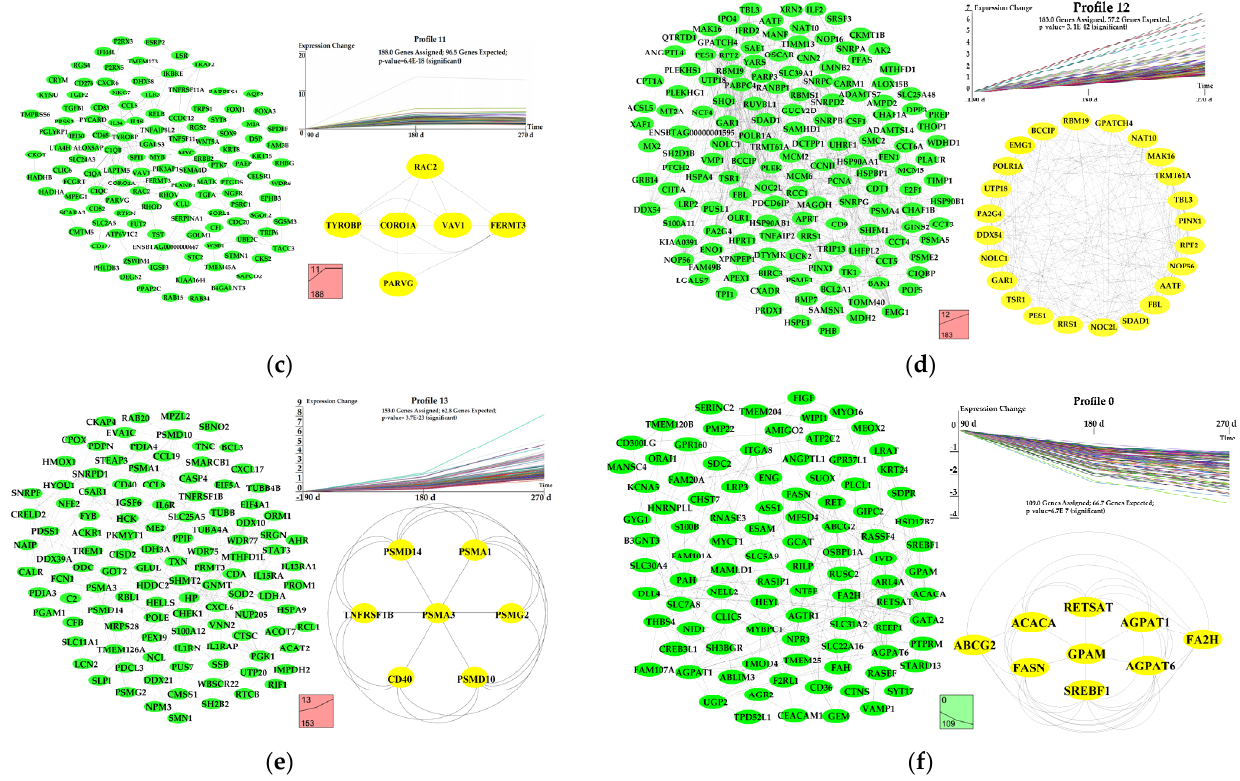
Figure 6. Patterns of gene expression across the three time points inferred by STEM analysis. ( a ) Sixteen candidate profiles were obtained via STEM analysis. The five colored profiles are significant profiles (FDR ≤ 0.05). ( b – f ) The green nodes in the PPI networks represent genes in the significant profiles. The yellow nodes in the PPI networks represent key genes in the significant profiles.